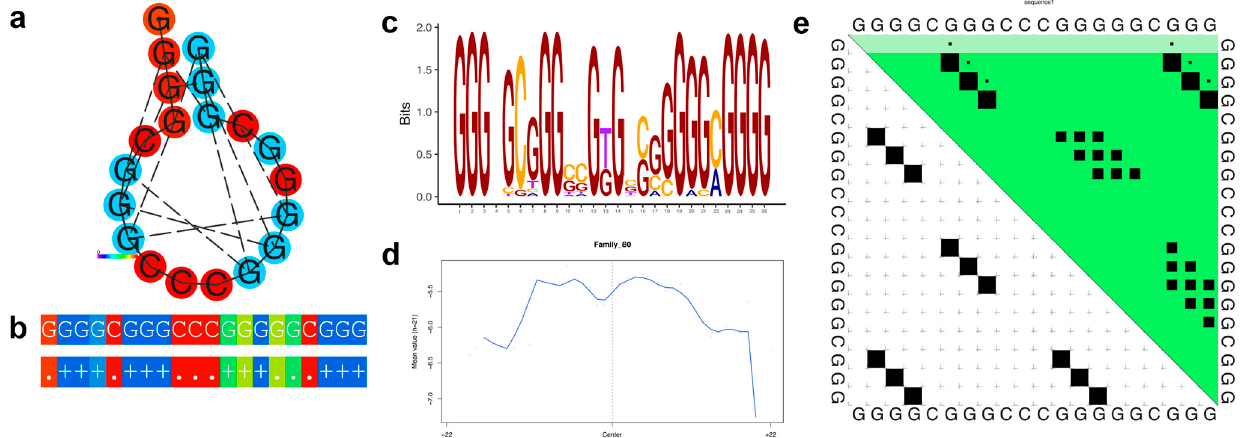
Figure 6. Thermodynamic properties for Family 80. ( a ) Centroid secondary structure with a minimum free energy of -17.38 kcal/mol using the consensus sequence of the family. ( b ) Dot-bracket notation showing the secondary structure. ( c ) Sequence logo representing the per base information content. ( d ) Electrostatic potential generated from all the sequences of the family using 10 flanking bases on either side of the identified G4. ( e ) Dot plot showing the substructures with the highest probabilities.